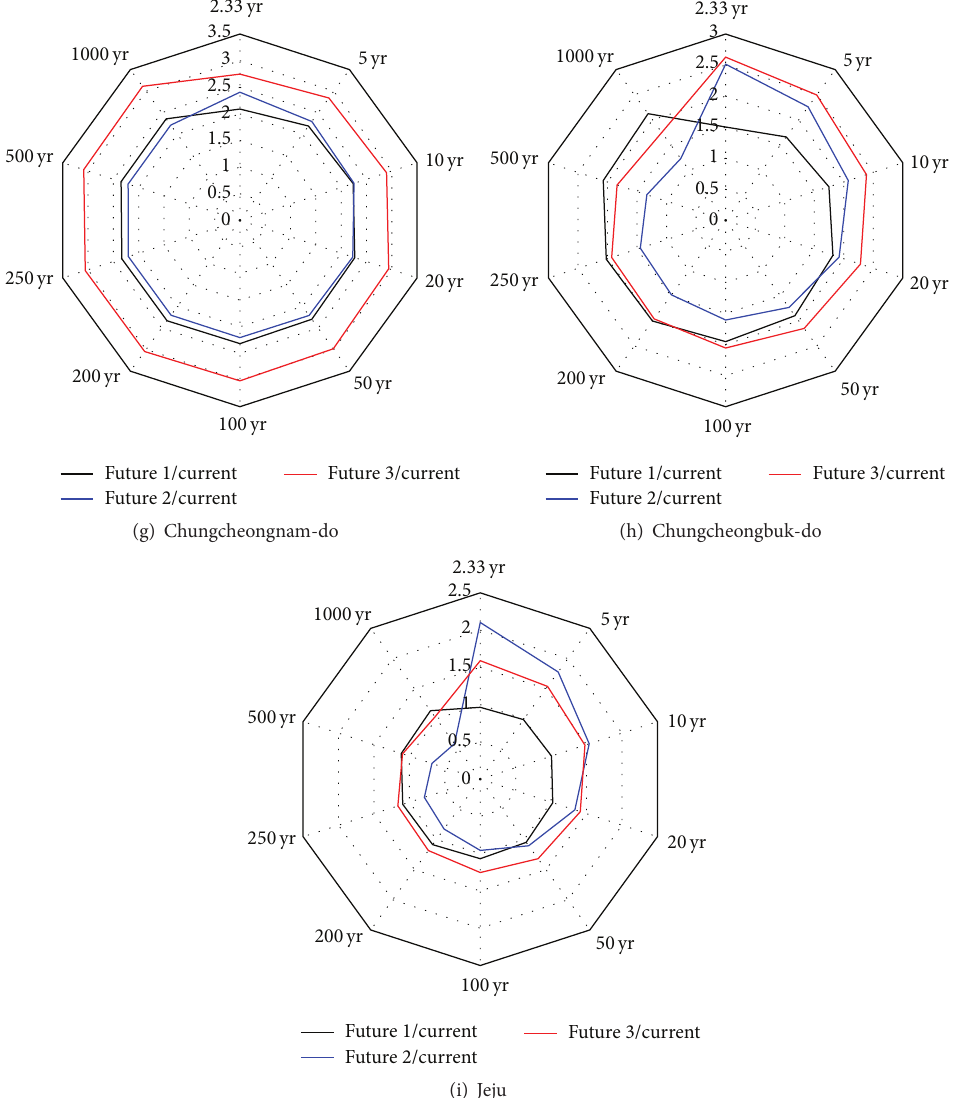
Figure 7: Ratio of total drought in the future climate to the current